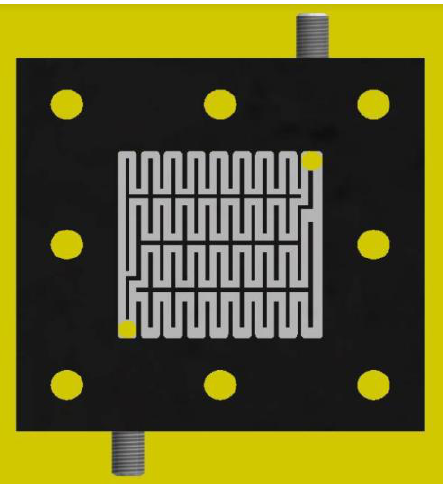
The overall reactions of the positive and negative redox couples electrolytes for the